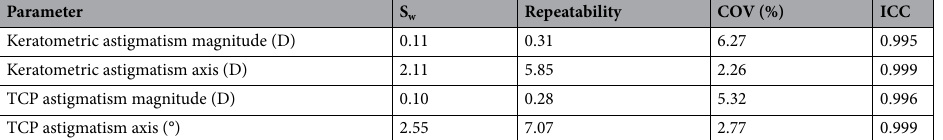
Table 2. Repeatability of astigmatism measurements in eyes with keratometric astigmatism > 1.0 D. Sw within- subject standard deviation, COV Coefficient of variation, ICC Intraclass correlation coefficient, TCP total corneal